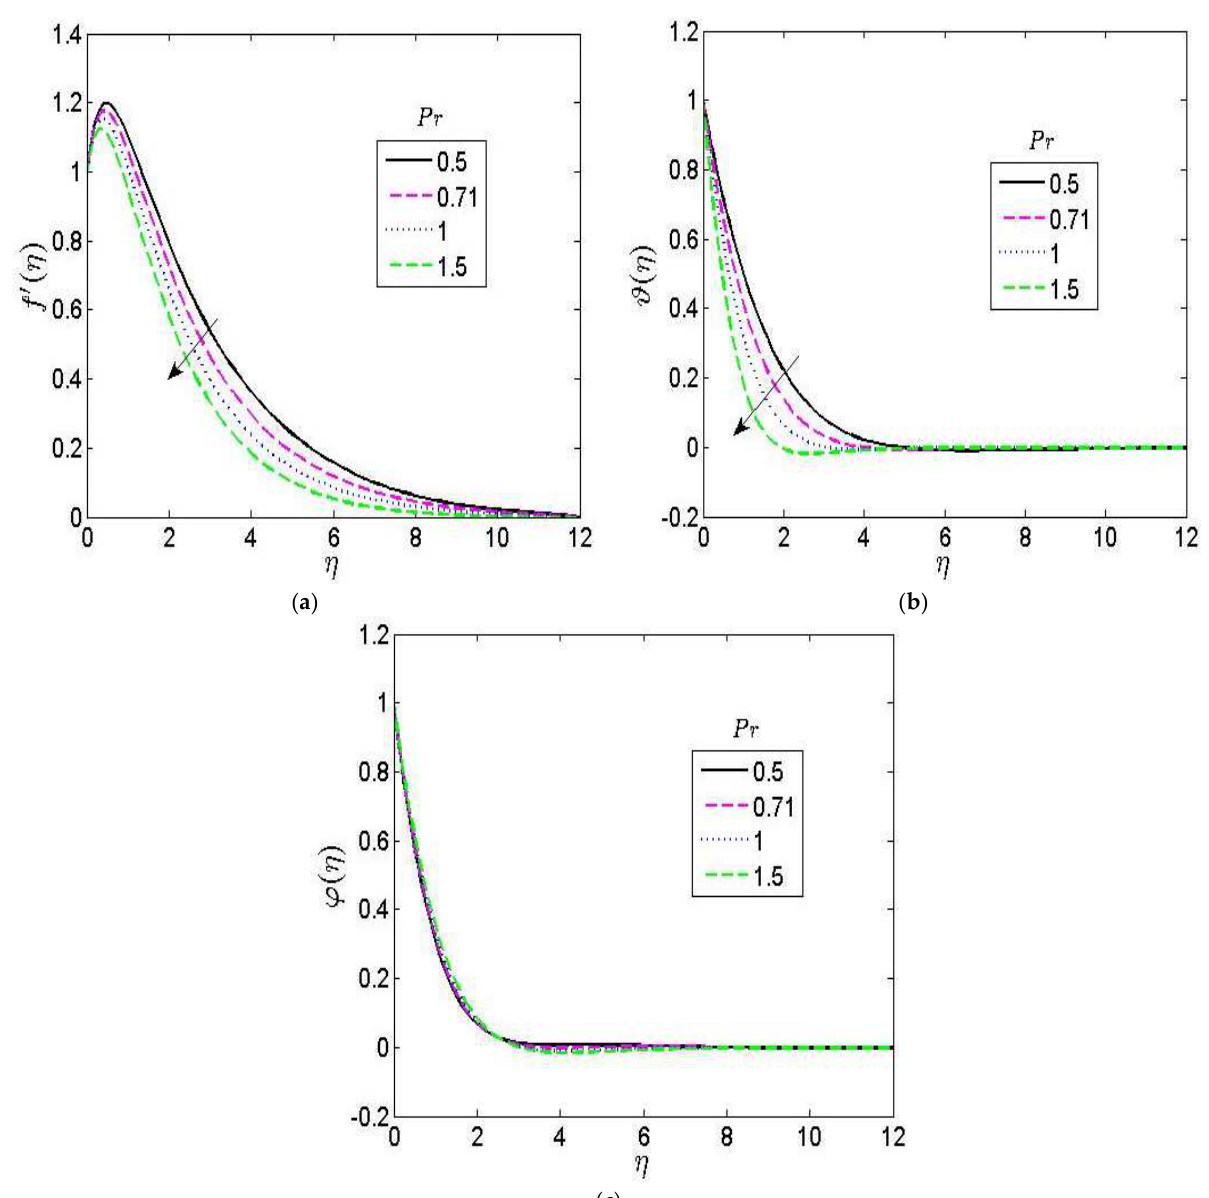
Figure 4. Effect of Prandtl number Pr on ( a ) velocity, ( b ) temperature, and ( c ) concentration profiles. Figure 5 represents the contribution of the viscous/energy term (i.e., Eckert) on temperature and velocity, as well as concentration distributions. The viscous/energy dissipation represents the relationship existing between the kinetic energy of fluid movement and the enthalpy. It is obvious from Figure 5a,b that as the Eckert number increases, elevation in the velocity and temperature of the fluid is observed.